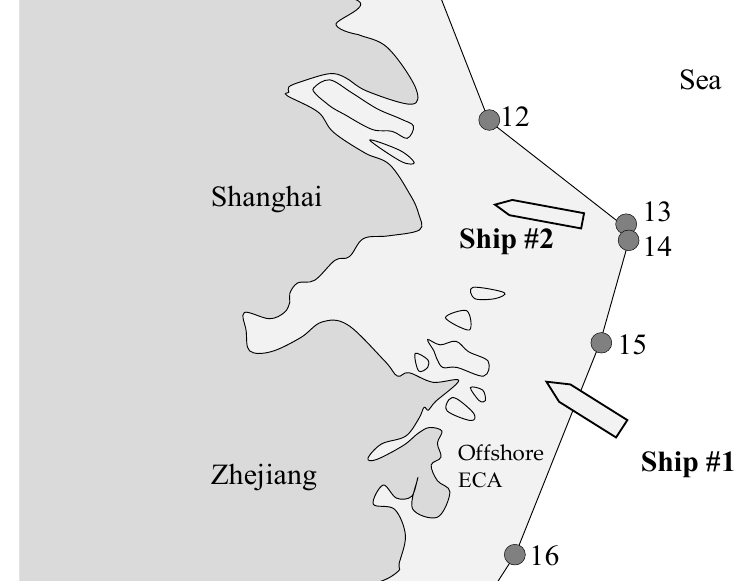
Figure 6. An ECA around Shanghai.